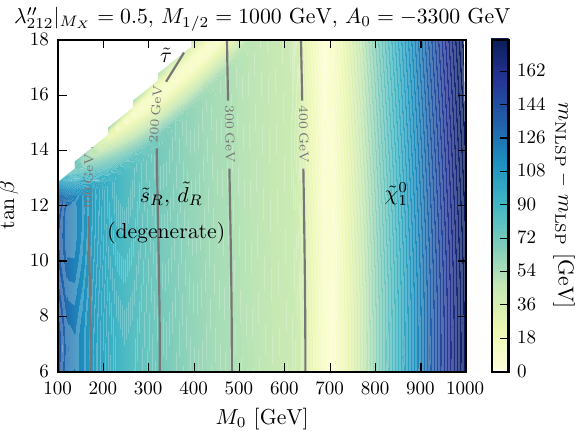
Fig. 4 Different LSPs in the M 0 –tan β plane for λ (cid:4)(cid:4) other parameters are M 1 / 2 = 1 TeV and A 0 = − 3 . 3 TeV. The white = 0 region in the upper-left corner corresponds to a tachyonic stau and/or squarks. The other labels are as in Fig. 3 region is a ˜ ν τ -LSP obtained. The white region in the lower- left corner results in